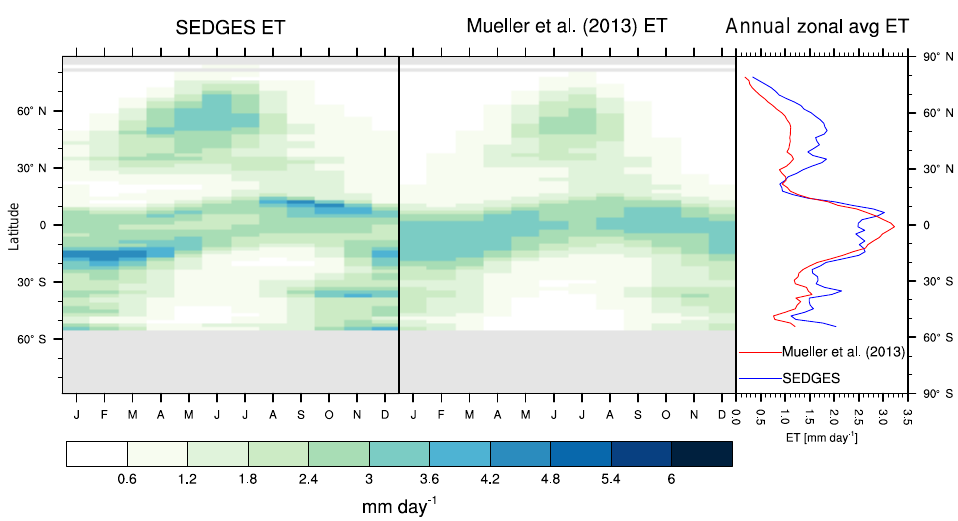
Figure 3. Zonal multiyear monthly means and zonal multiyear annual means of ET for SEDGES and the Mueller et al. (2013) reference dataset for the 1989–2005 period over non-glaciated